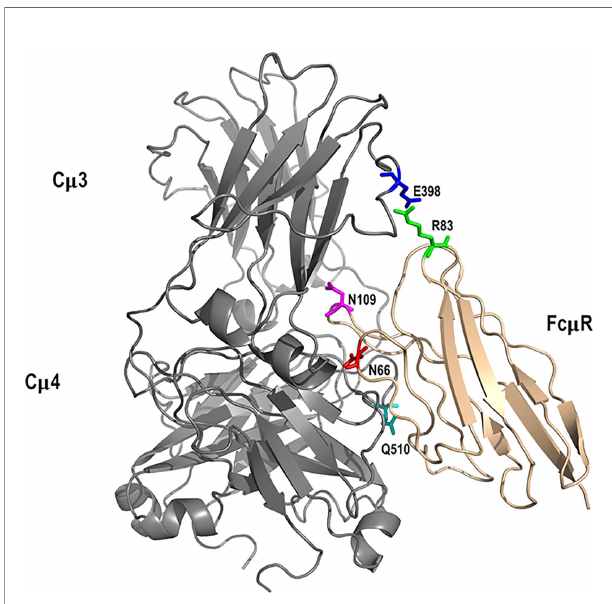
FIGURE 7 | Interaction between FcµR and IgM-Fc subunit. Key residues in the modeled complex between the Ig-like domain of FcµR (tan) and an IgM- Fc subunit (grey) are indicated. They include N66 (red), R83 (green), and N109 (magenta) for FcµR and E398 (blue) and Q510 (cyan) for IgM-Fc. These residues, with the exception of E398, are based on our present and earlier experimental results